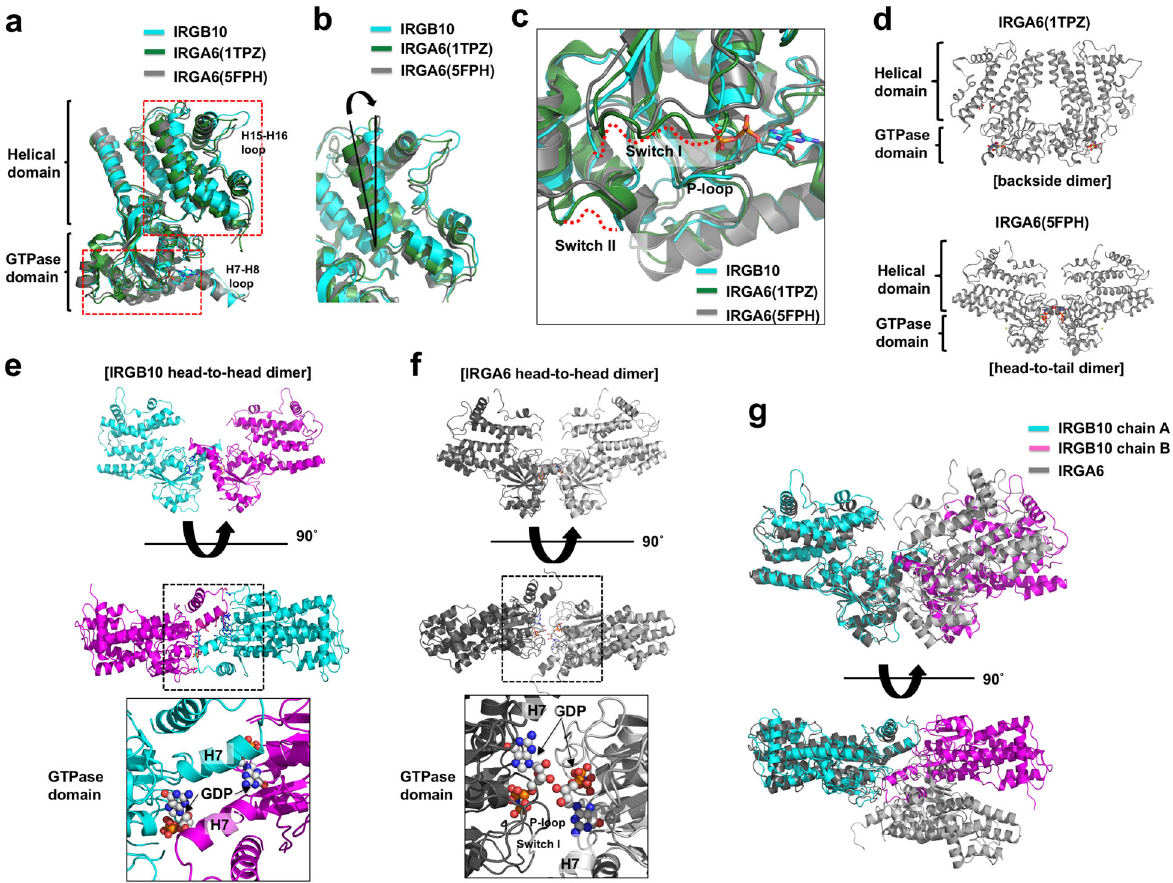
Fig. 4 Structure comparison of IRGB10 with IRGA6. a The superposition of IRGB10 with IRGA6. Two IRGA6 structures were used for the comparison. Red dotted line boxes indicate the two main regions that are magni fi ed in ( b ) and ( c ). The position of two loops, the H7 – H8 connecting loop (H7 – H8 loop) and H15 – H16 connecting loop (H15 – H16 loop), whose structures are not identical to each other, are labeled. b Close-up view of the superposed helical domains. c Close-up view of the superposed GTPase domains. The unconstructed loops (switch I and switch II) are indicated by red dotted lines. The location of the P-loop is labeled. d Putative dimer structures of IRGA6 reported by previous structural studies. Two putative models are introduced. e and f Comparison of dimer interface of IRGB10 ( e ) with that of IRGA6 ( f ). Side view and top view of head-to-head dimer are shown at the upper and middle panels, respectively. Magni fi cation of top view on GTPase domain are shown at lower panel. Black-dot box in the middle panels indicates the magni fi ed site. g Superposition of IRGB10 head-to-head dimer with that of IRGA6. Cyan and magenta color indicate dimeric molecules of IRGB10, while the gray color indicates dimeric molecules of